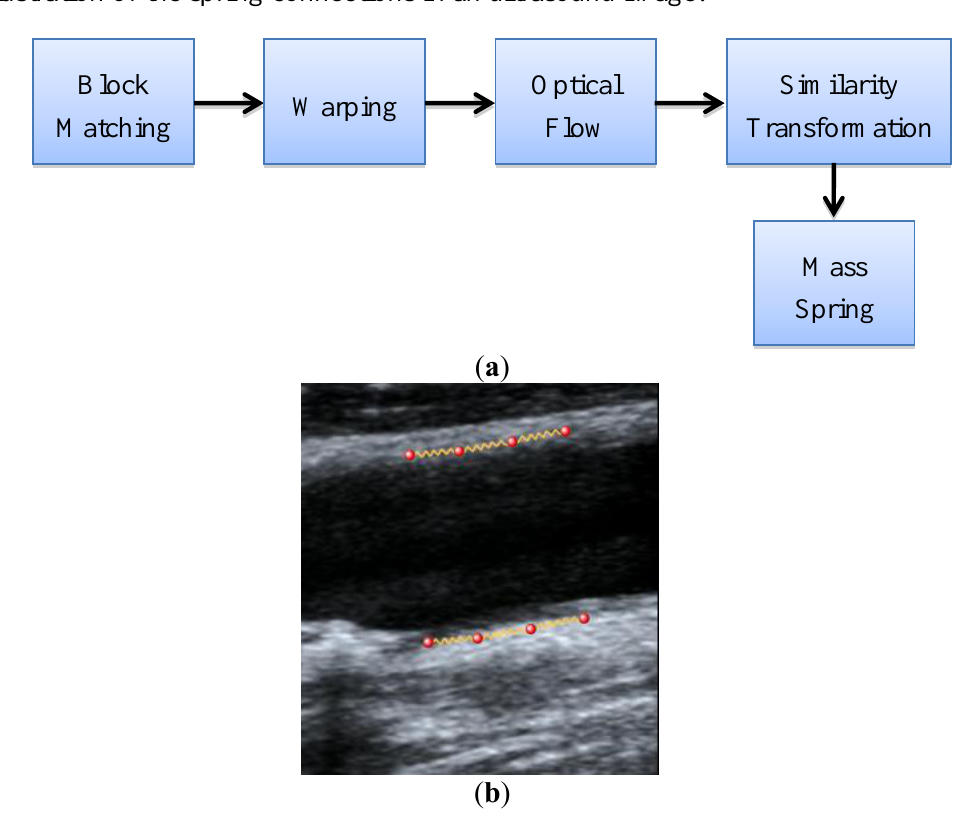
Figure 4. ( a ) Pipeline of the proposed method with physics simulation (mass-spring) and ( b ) Illustration of the spring connections in an ultrasound